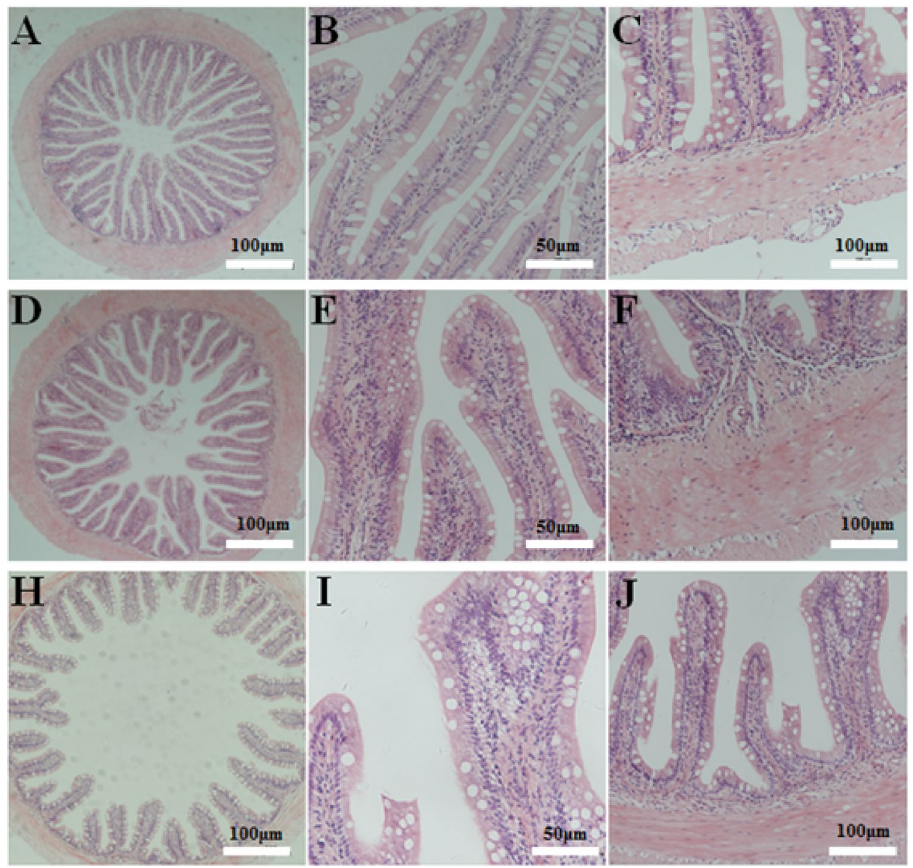
Figure 1. Hematoxylin–eosin staining in the DI tissues of pearl gentian grouper. Note: Representative histomorphological images from hematoxylin and eosin-stained sections of the distal intestine of grouper juvenile depicting the inflammatory changes in grouper on FM ( A , B , C ), SBM20 ( D , E , F ) and SBM40 ( H , I , J ) diets. ( A , D , H ) Representative images of decreased height and increased fusion of the mucosal folds in SBM20 and SBM40 groups. ( B , E , I ) Representative images of increased width and cellular (leucocyte) infiltration (asterisk) of the lamina propria (arrows) in SBM20 and SBM40 groups. ( C , F , J ) Representative images of increased width and cellular (leucocyte) infiltration of the submucosa. FM refers to the fish meal control group, SBM20 refers to the 20% SBM protein replacement level to FM protein, and SBM40 refers to the 40% SBM protein replacement level to FM protein.